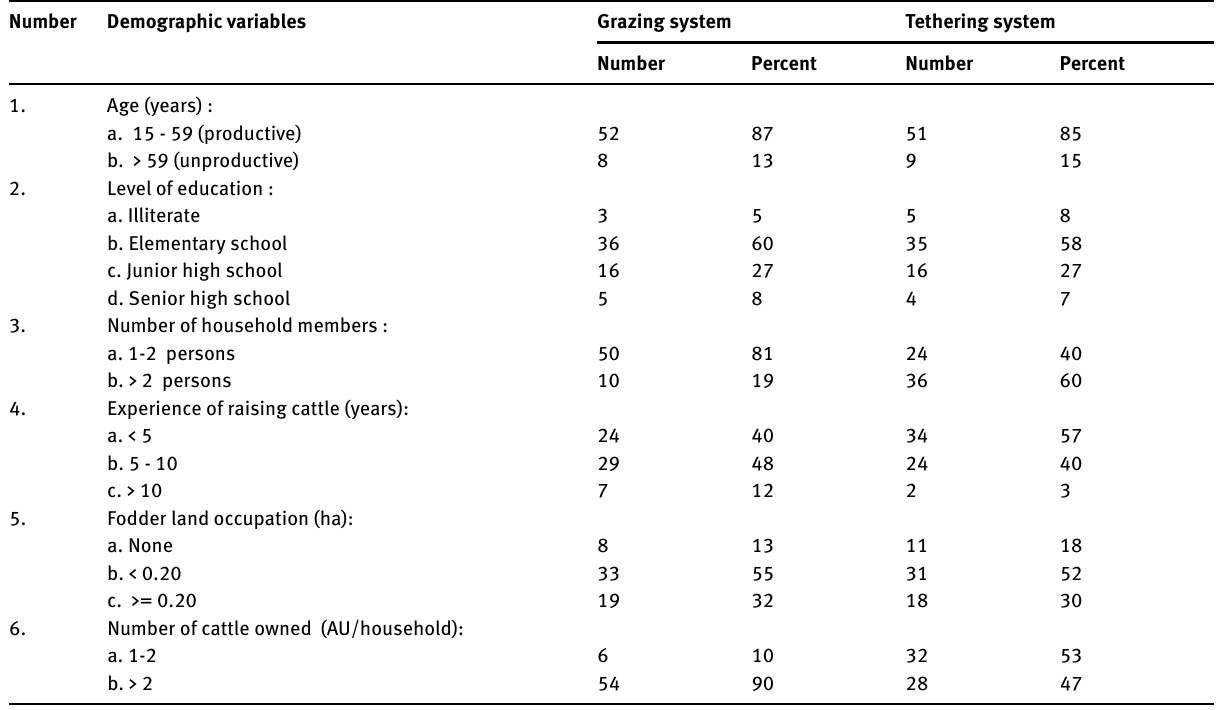
Table 2: Socio-economic characteristics of respondents Number Demographic variables Grazing system Tethering